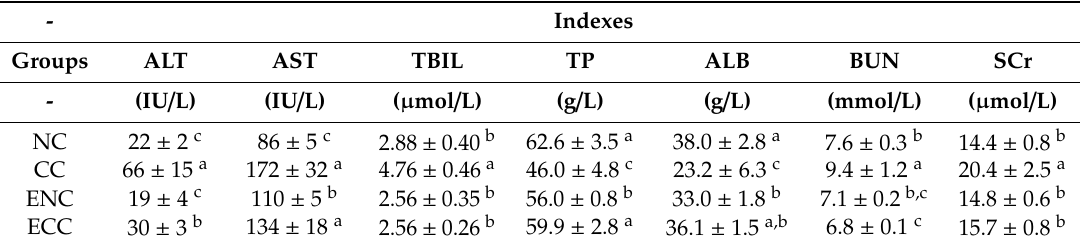
Table 8. Blood indexes of ICR